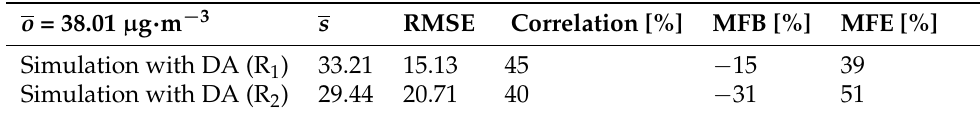
Table 6. Statistics of hourly simulated PM 2.5 concentrations with DA using two influence radii R 1 and R 2 to AirBase measurements comparisons during March 2009. s and RMSE are expressed in µ g · m − 3 .